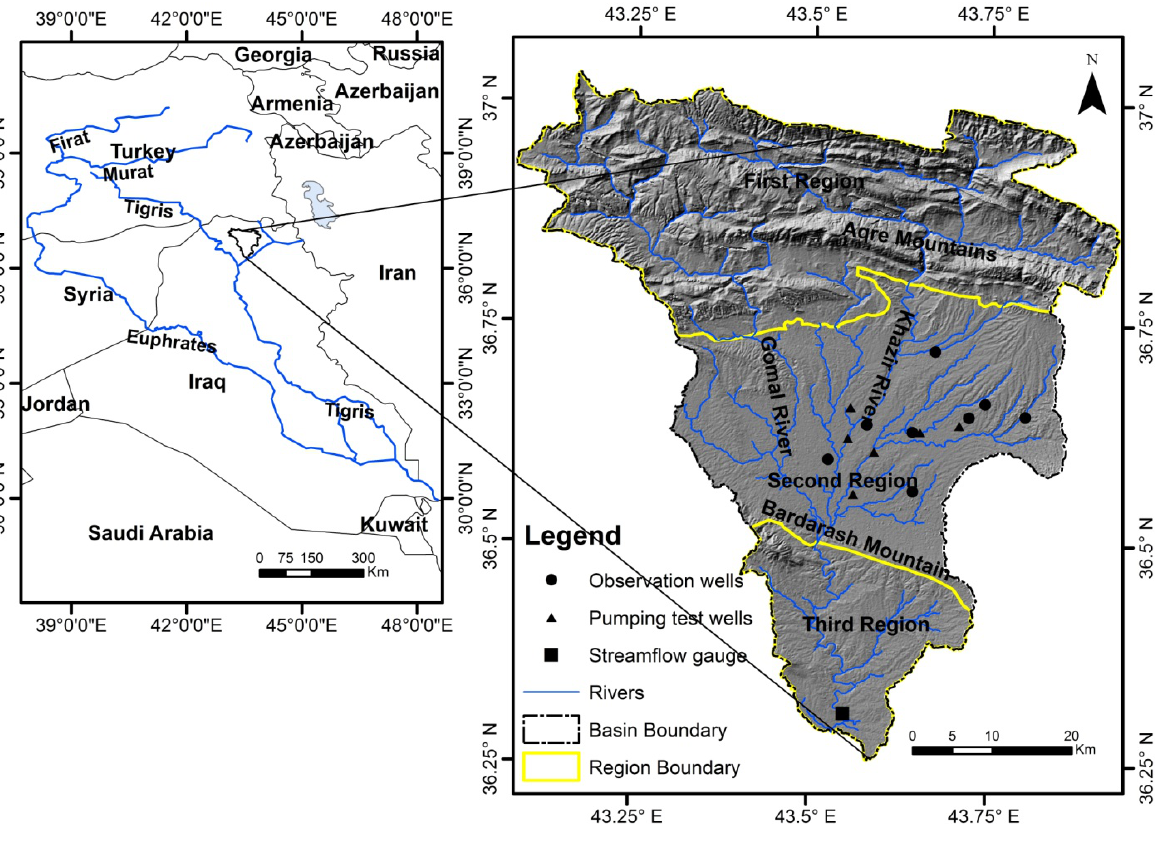
Figure 1. Map of Al-Khazir Gomel basin illustrating the basin boundary, the three regions’ boundaries, the stream-flow gauge and pumping and observation